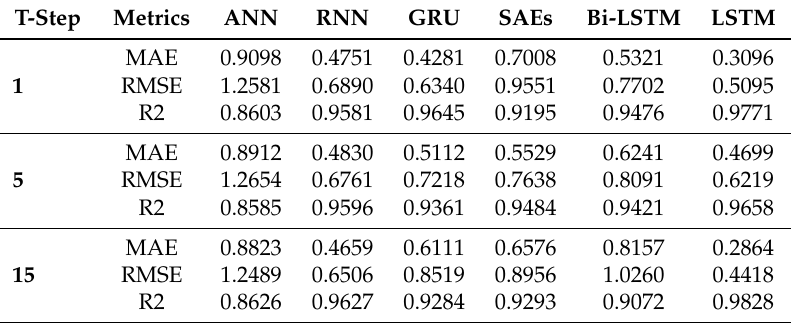
Table 3. Performance comparison of the MAE, the RMSE, and the R2 for all